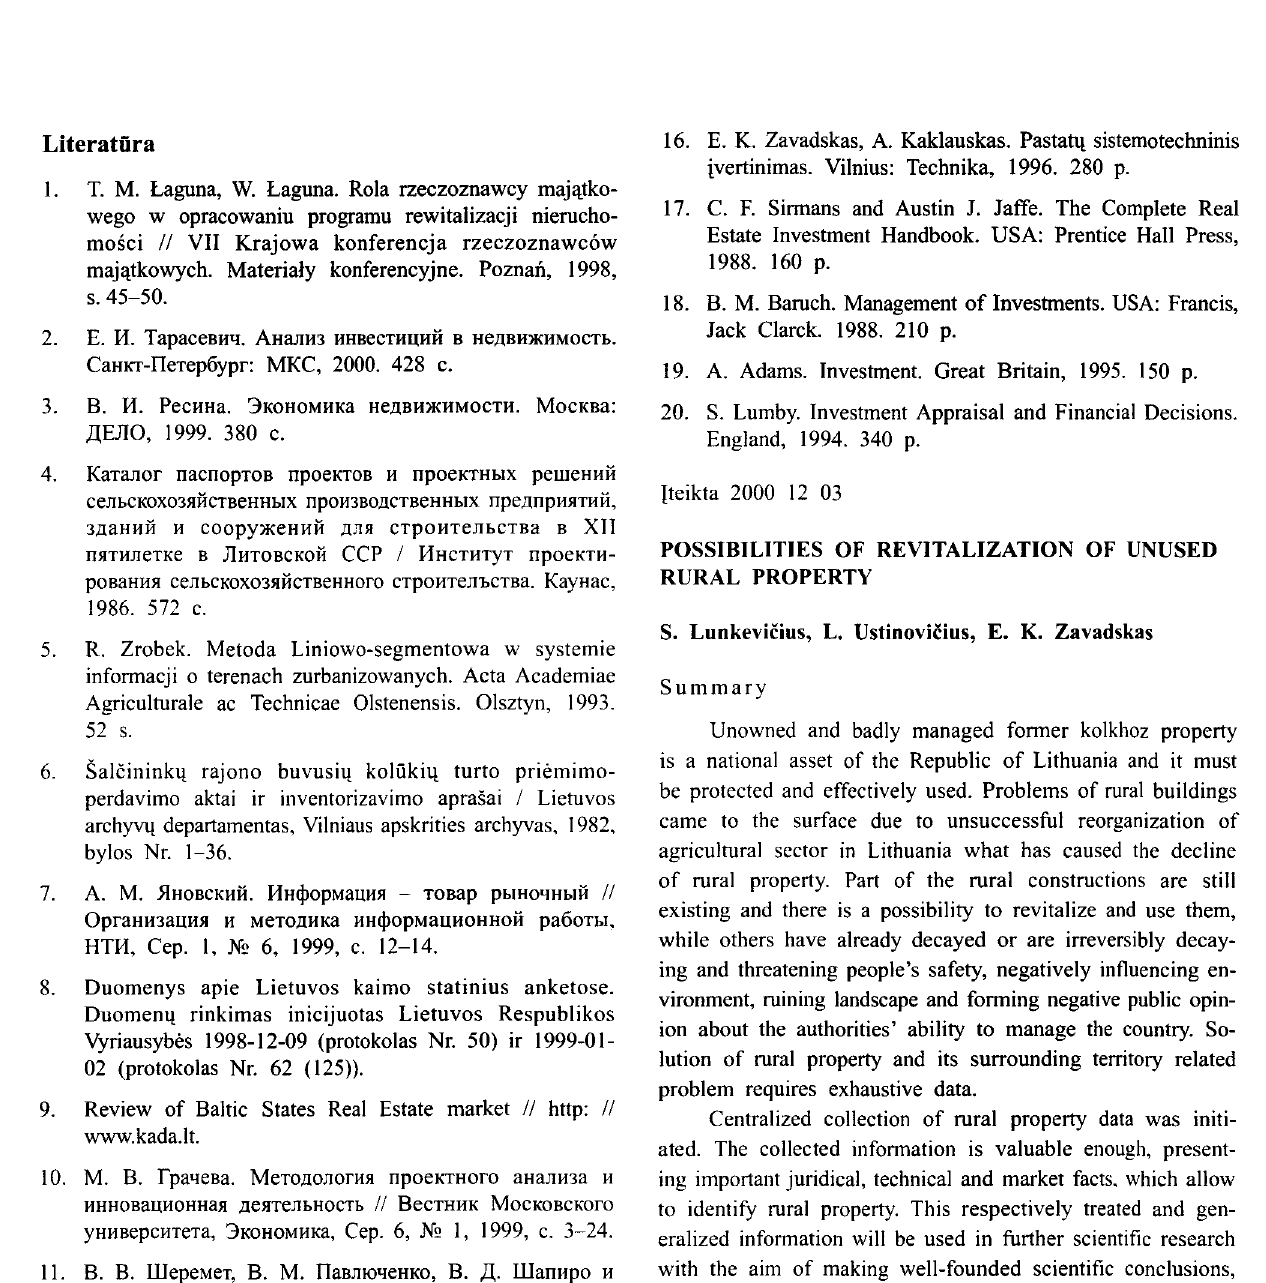
m Fig 8. Revitalization process contains six